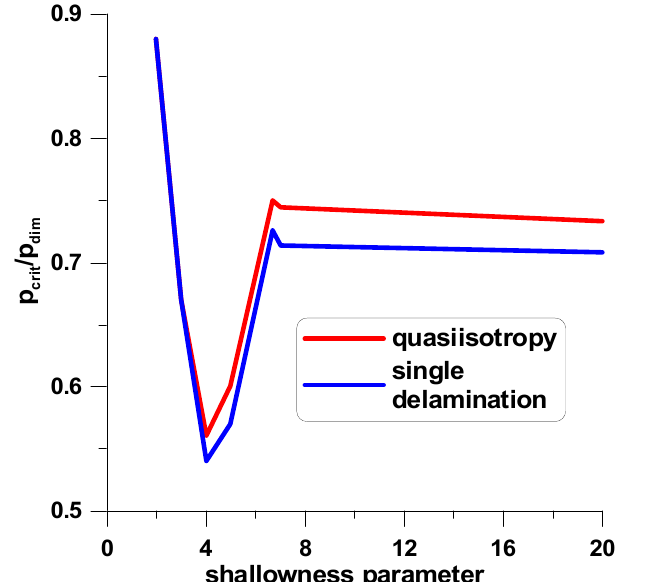
Figure 16. Buckling modes of axi-symmetric spherical shell with a single delamination being the function of the shallowness parameter ρ .